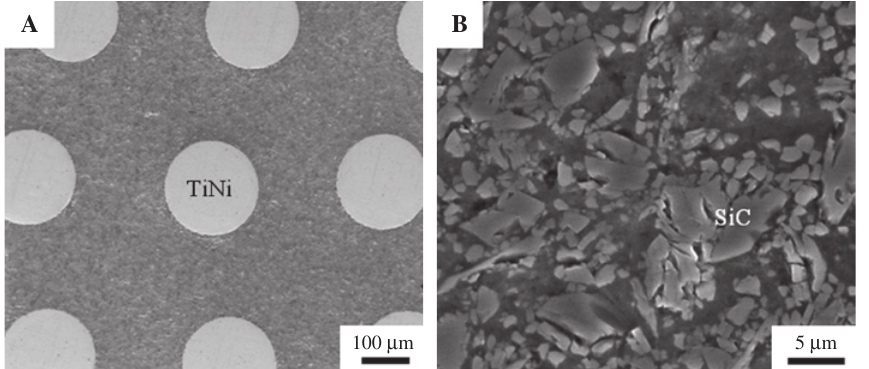
+TiNi /Al composite: (A) arrangement of TiNi p f